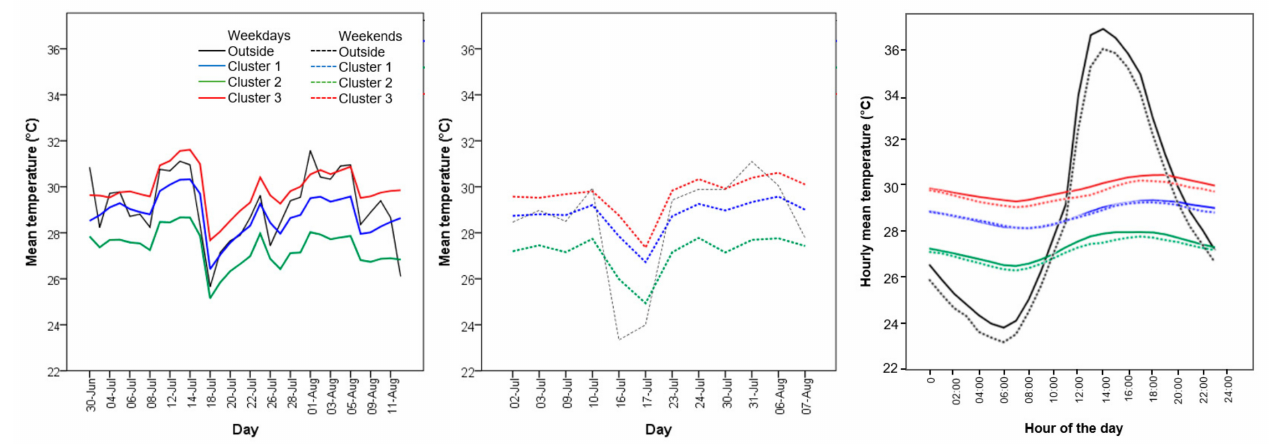
Figure 4. Mean daily temperature for weekdays ( left ) and weekends ( centre ); mean hourly tem- perature profiles for both weekdays and weekends ( right ) of the three clusters, together with external temperature. Table 3. Descriptive analysis of the mean temperature of each cluster based on the mean temperature of each dwelling and Levene’s test results in summer. N Mean SD F Sig. Cluster 1 25 28.3 0.4 Weekdays 7.230 0.002Cluster 2 14 26.8 0.7 Cluster 3 10 29.7 0.3 Cluster 1 24 Weekends